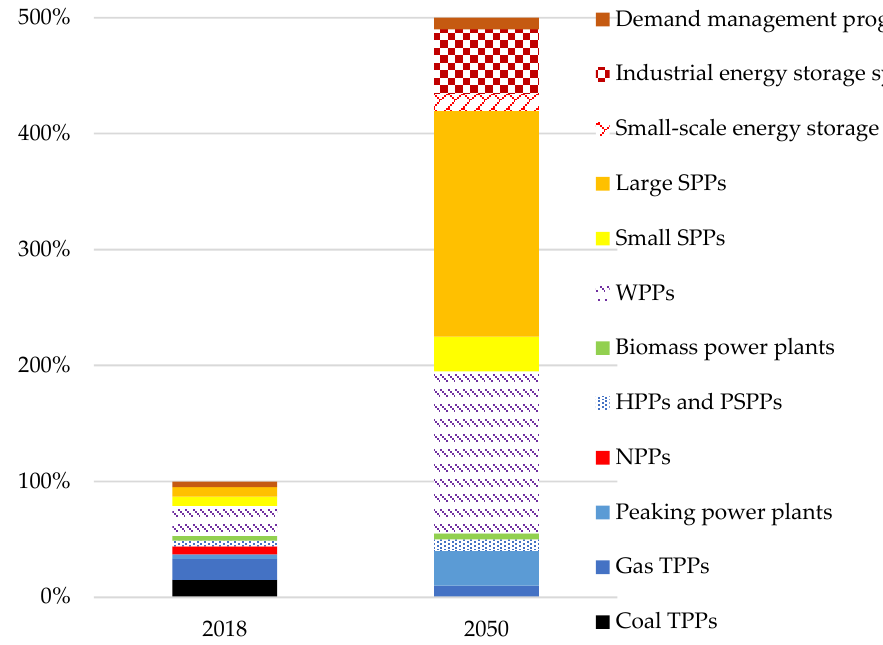
Figure 6. Changes in the installed plant capacity in Europe as a result of the energy transition (the data for 2018 is taken as 100%).